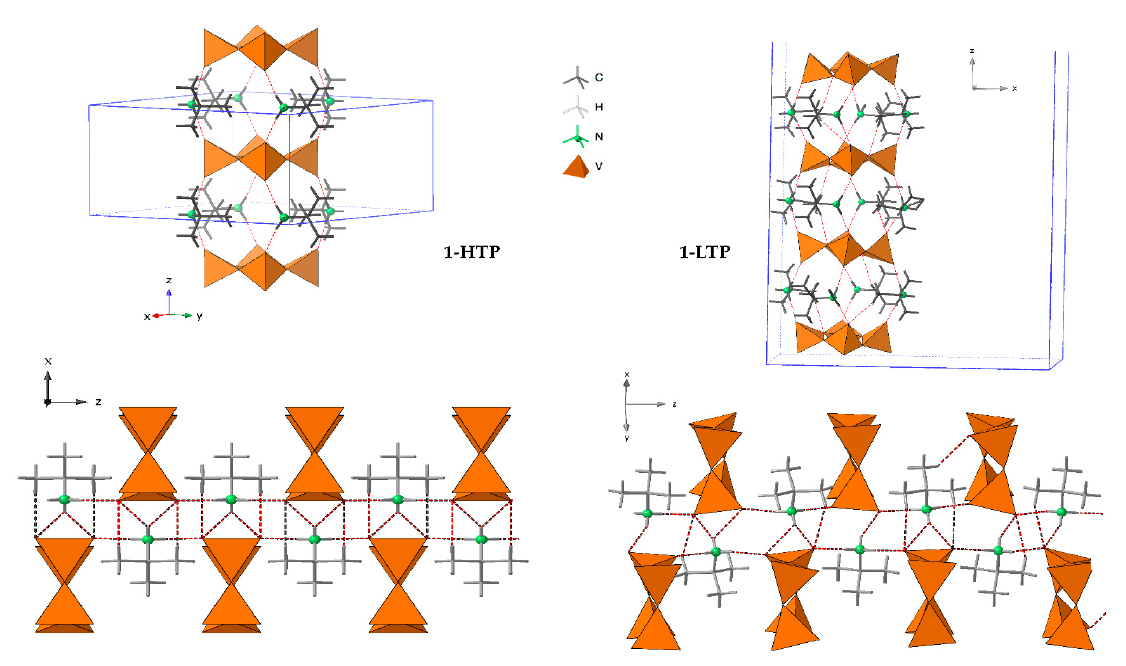
Figure 3. Crystal packing of 1-HTP at the left and 1-LTP at the right. Consequently, these H-bonds allow the structure to form chains through the V 4 O 12 cycles, where the holes in each polyanionic chain means a 4.6% and a 4.8% of the total cell volume of 1-HTP and in 1-LTP , respectively (Figure 4).